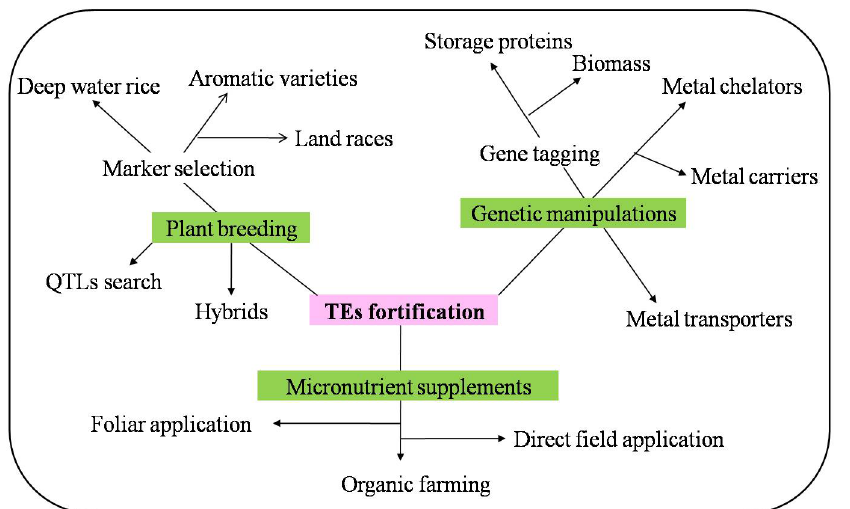
Figure 4. TEs fortification strategies for